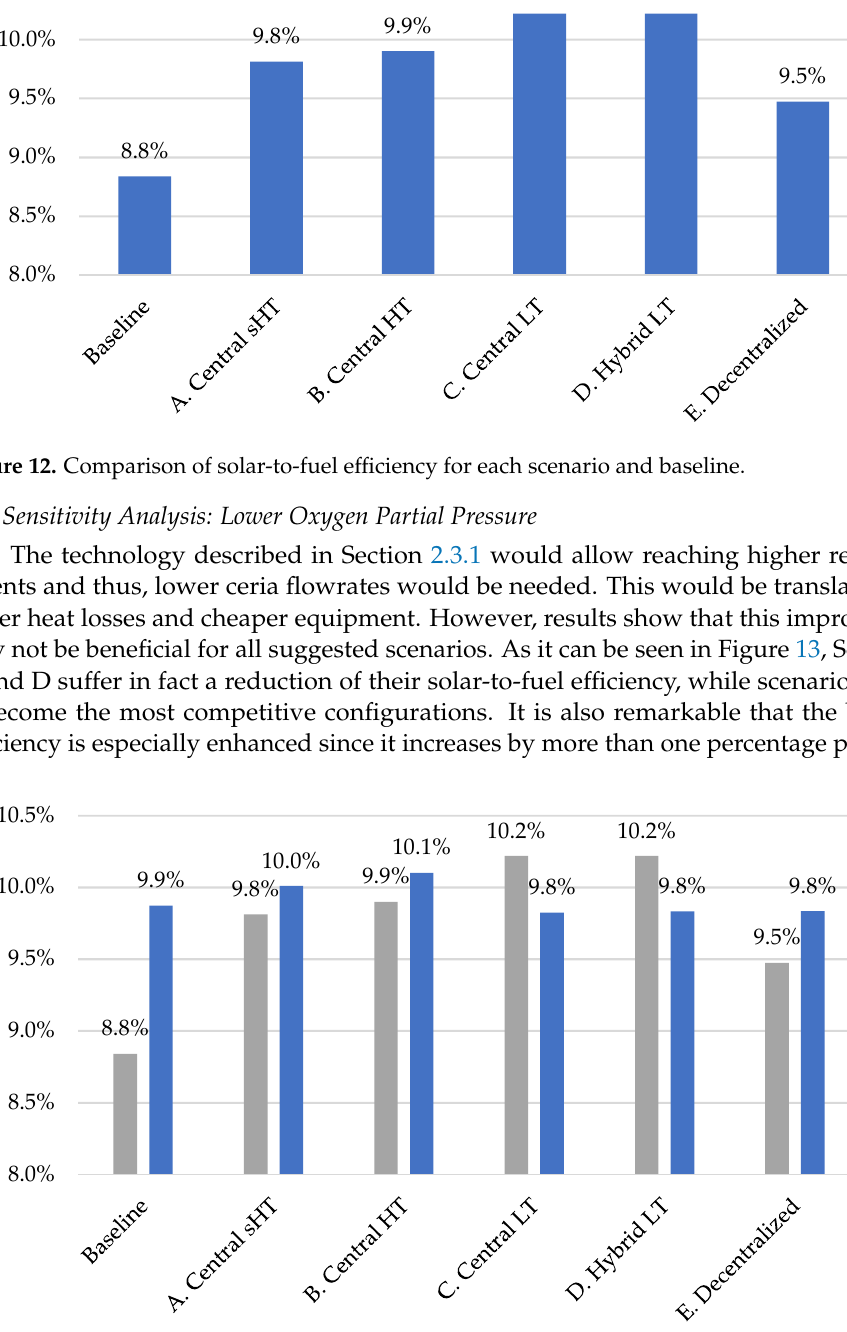
Figure 13. Impact of a hypothetical reduction of oxygen partial pressure in the reduction step on the solar-to-fuel efficiency of each scenario. Above each scenario, two bars are shown: gray bars (left) show the previous values and blue bars (right), the recalculated